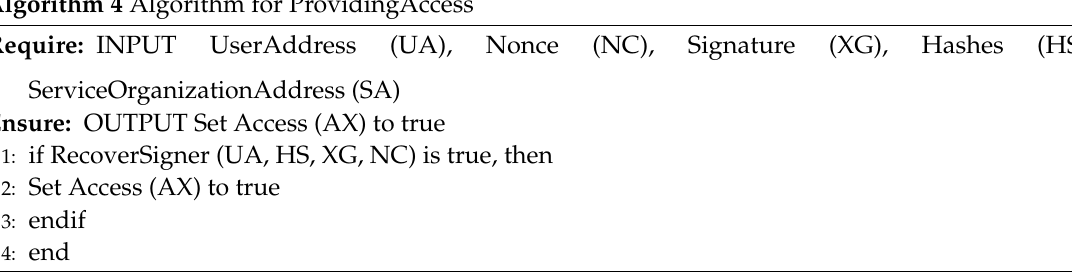
Algorithm 4 Algorithm for